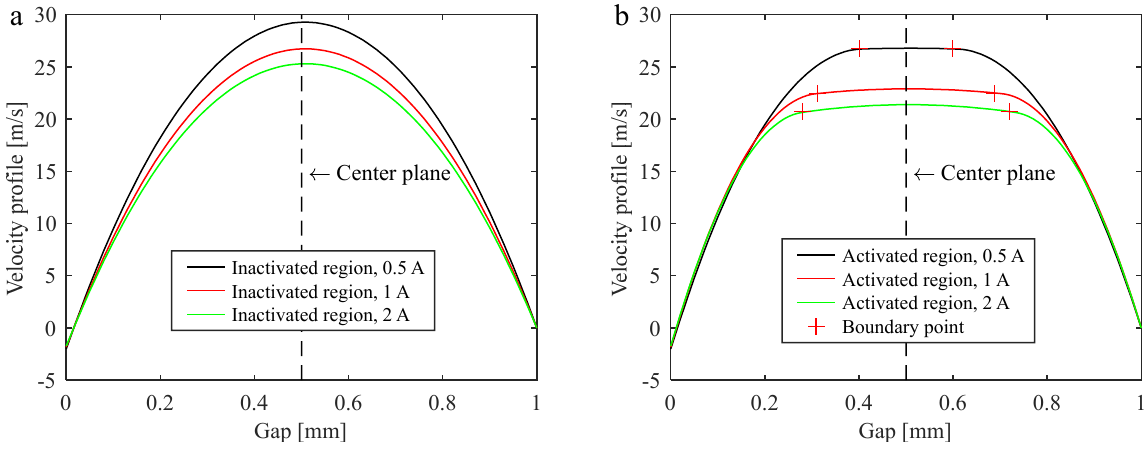
Figure 14. Peak velocity profiles for different excitation currents.